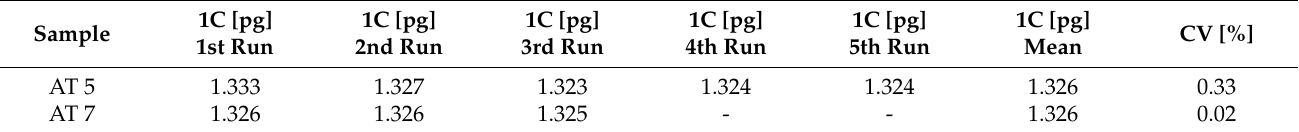
Figure 3. Cluster dendrogram based on the Nei’s genetic distances among populations. Codes of the samples (AT1, AT3, AT4, AT5, AT6, AT9) are given according to Table 6. Table 4. DNA content in fresh leaves.